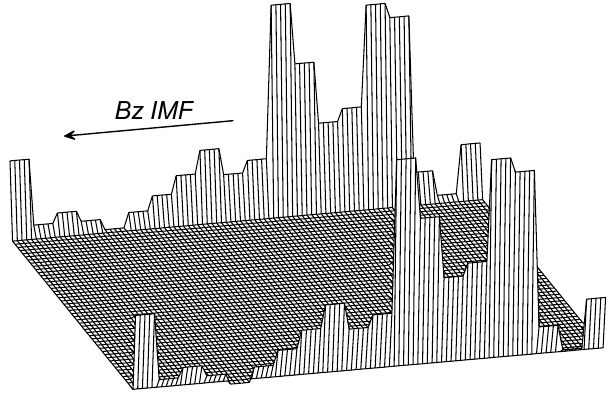
Fig. 1. Scheme of the “magnetospheric” array and boundary condi-